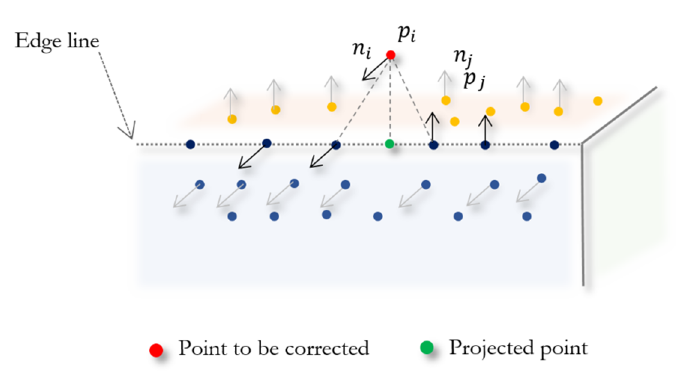
Figure 2. Edge points correction.